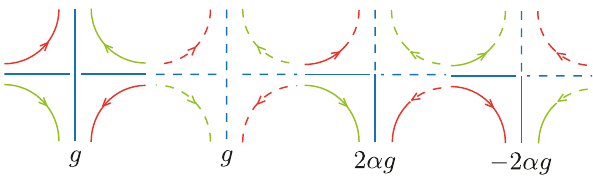
Figure 15 . The solid line is for ψ 1 and dashed ψ 2